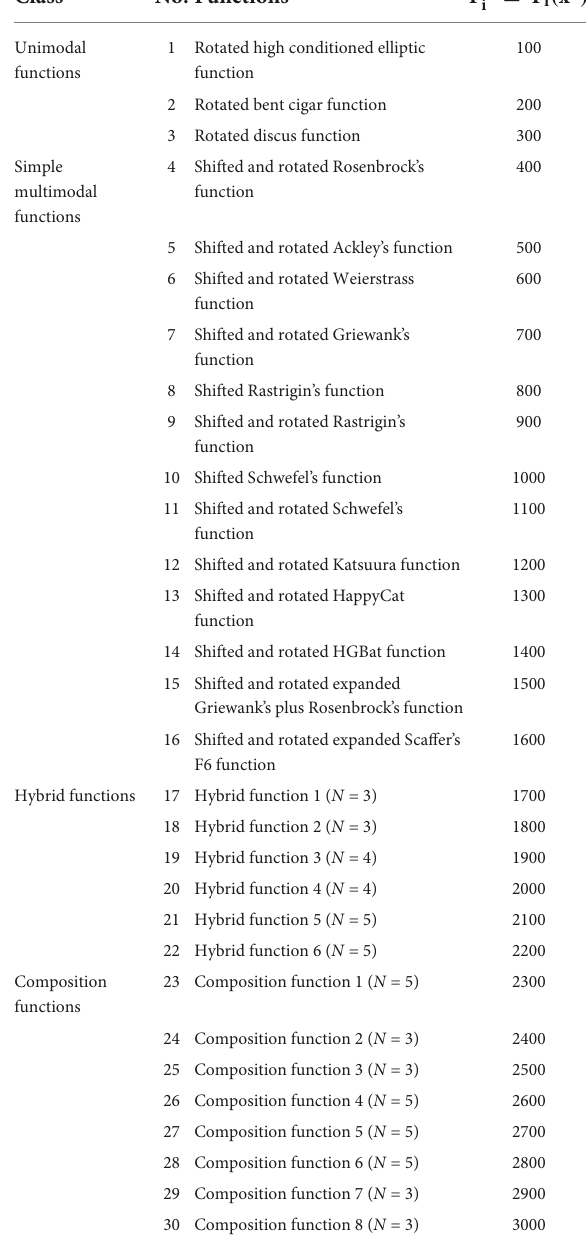
TABLE 4 Description of the 30 benchmark